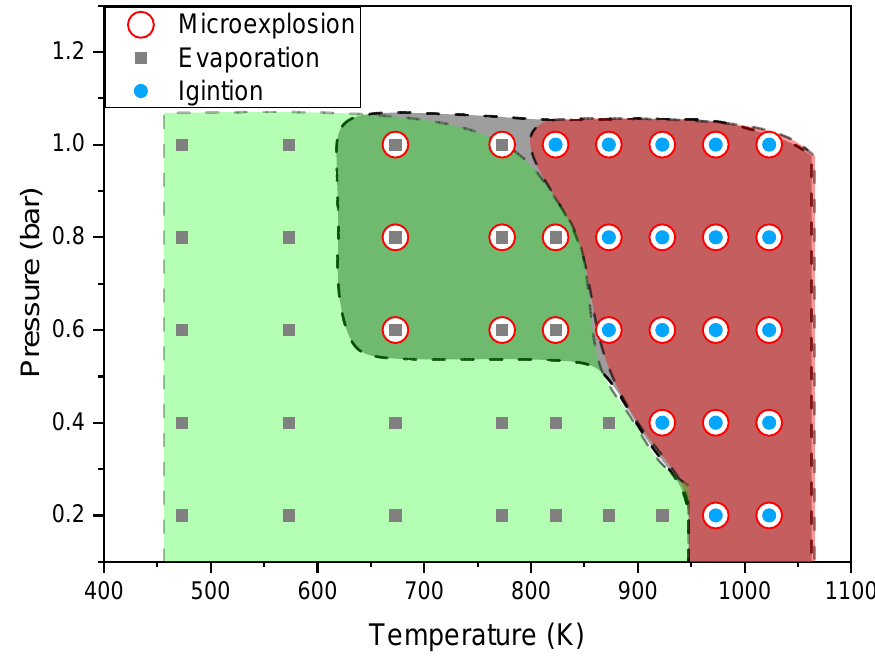
Figure 12. Diagram of droplet state under all experimental conditions.